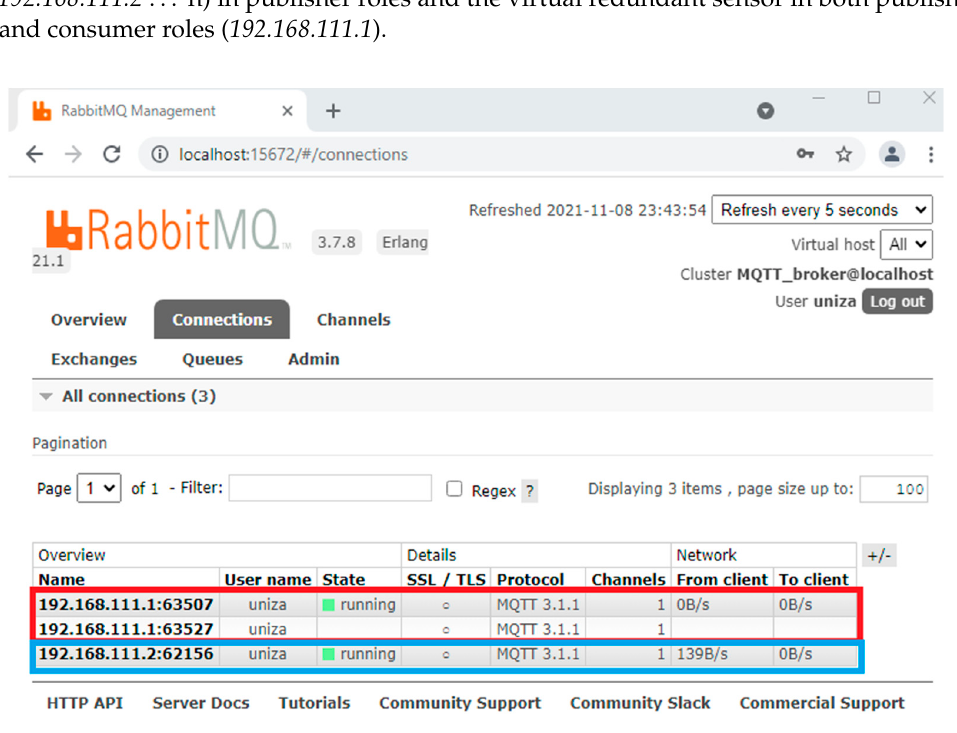
Figure 10. RabbitMQ queue setting for virtual redundant sensor as a consumer. In our experimental case, the physical sensors are emulated purely by software client, which can send manual input, or simulated values to MQTT broker via MQTT client in Producer role. A simulation of the input is based on the random value generator, which